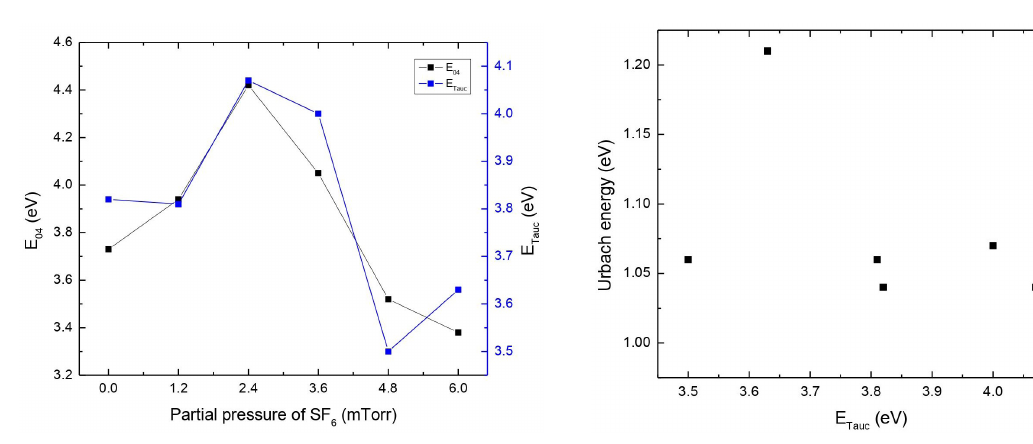
Figure 9. Refractive index of the films as a function of R